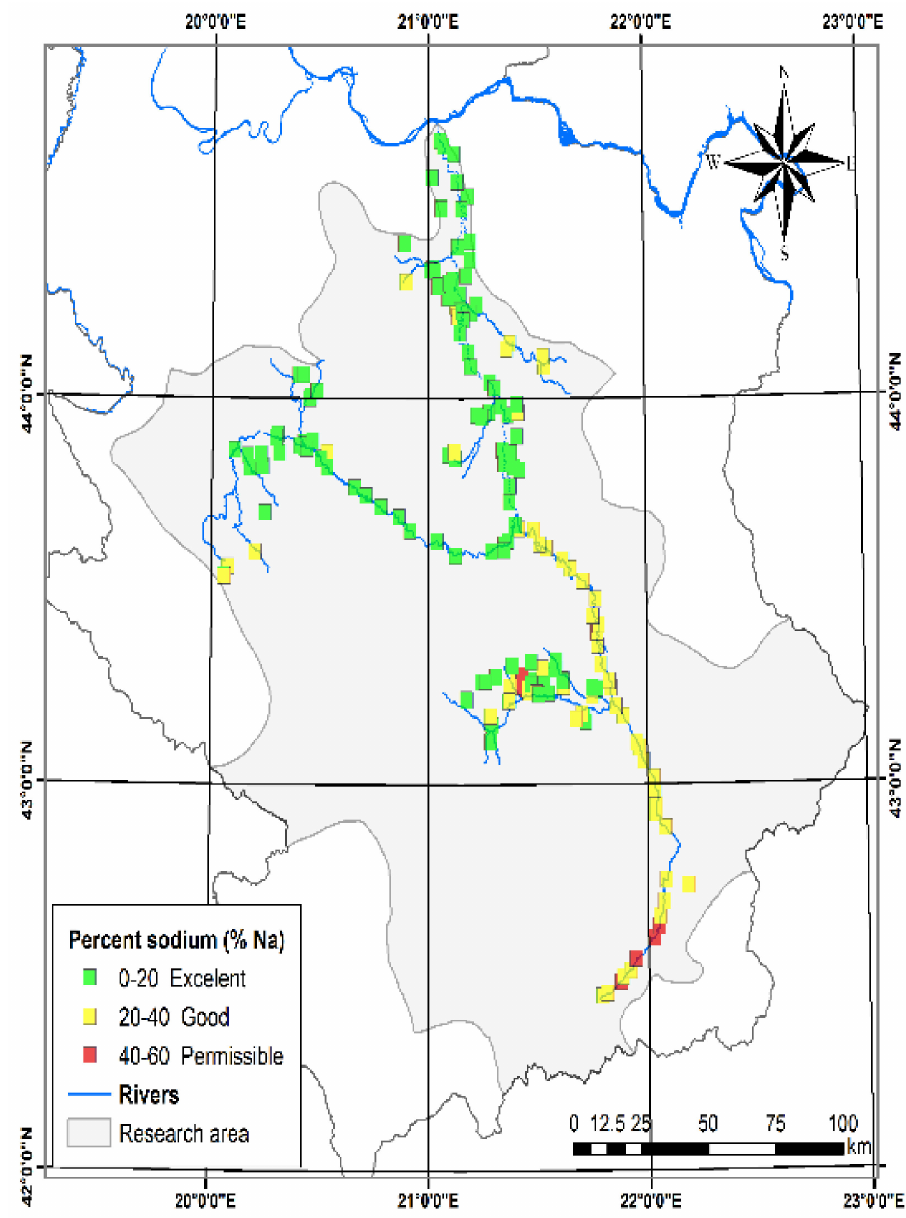
Figure 9. Spatial distribution of Na